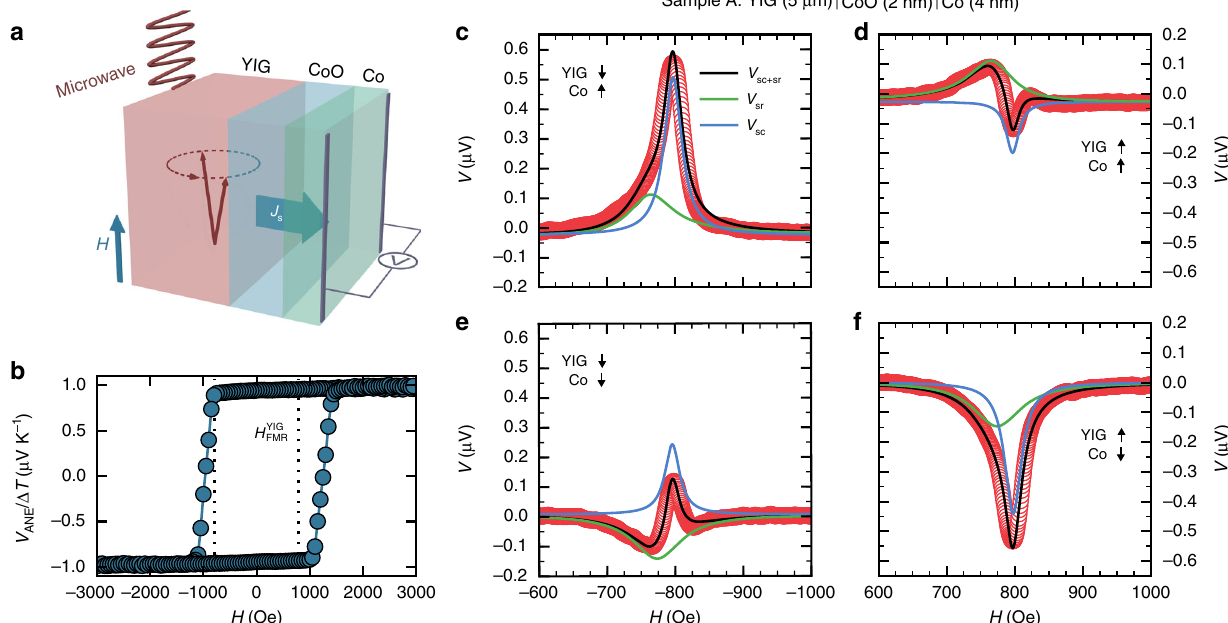
Fig. 1 Measurement concept and spin pumping voltage responses. a Illustration of the investigated Y 3 Fe 5 O 12 (YIG)|CoO|Co tri-layer system. A spin current J s induced in the YIG by ferromagnetic resonance (FMR) spin pumping propagates through the CoO intermediate layer and is detected electrically in the Co layer via the inverse spin Hall effect (ISHE). The relative magnetization orientation of YIG and Co can be adjusted to be either parallel or antiparallel. b Typical cobalt anomalous Nernst effect (ANE) hysteresis loop observed for sample A at T = 120 K, being fi eld-cooled at H ext = 90 kOe. Coercive fi elds of ½ H (cid:2) (cid:3) ≃ 1250 Oe [ − 970 Oe] and an elevated squareness V H ¼ 0 the Co layer of H þ c c sample A induced by microwave irradiation ( f = 4.5 GHz P abs ≈ 48 mW, and T = 120 K). The total signal is given by a superposition of two distinct signals V V V V sc and sr ; the sign of sc ( sr ) depends on the magnetization orientation of YIG (Co). While in the YIG fi lm, V sr inherently originates from the Co layer, potentially due to heating or spin recti fi cation effects. The amplitude of V sc depends on the relative alignment of YIG and Co. Microwave absorption spectra (see Supplementary Note 1) show that FMR of YIG is excited at this frequency at H